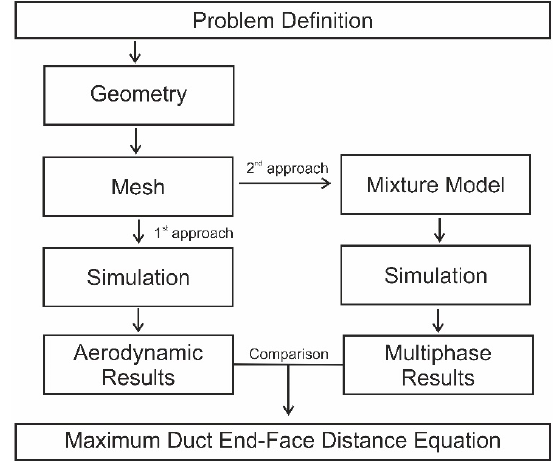
Figure 2. Flow chart that depicts the methodology followed .